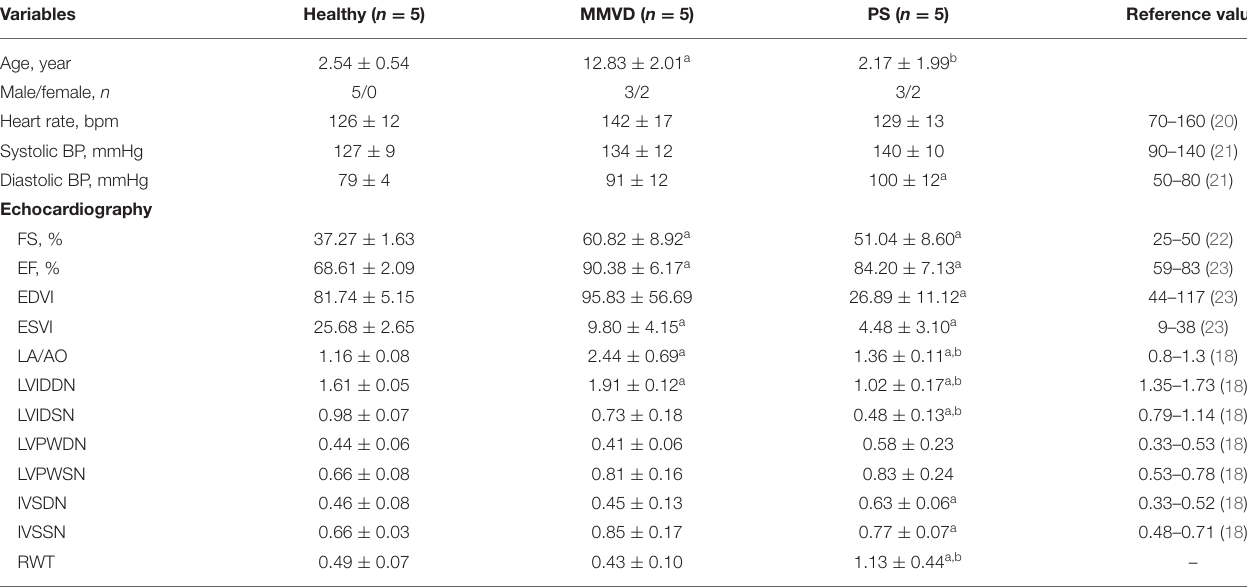
TABLE 1 | Clinical characteristics of dogs included in this